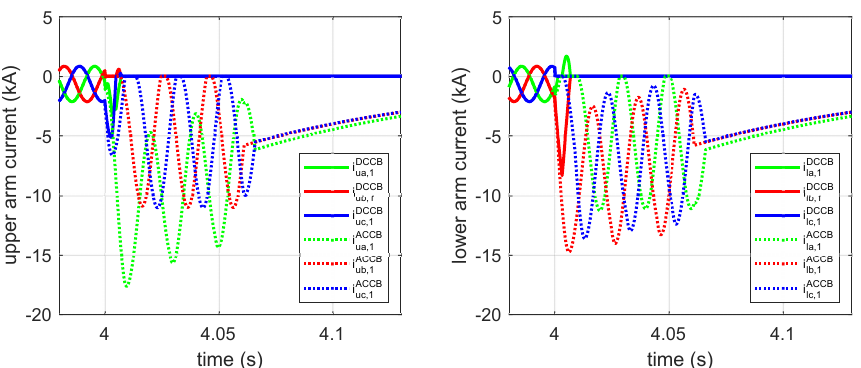
Figure 14. Upper and lower arm-currents during DC pole-to-pole fault with AC circuit-breakers (dotted lines) and DC circuit-breakers (solid lines); green for phase a, red for phase b and blue for phase